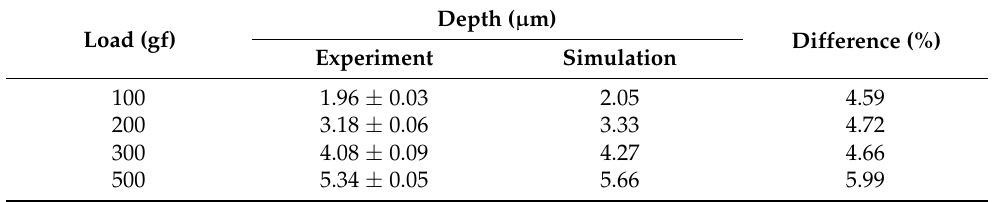
Table 10. Comparison of experimental (Table 3) and the corresponding simulation plastic indentation depth results of the Ti/SiC MMNC coating for different load